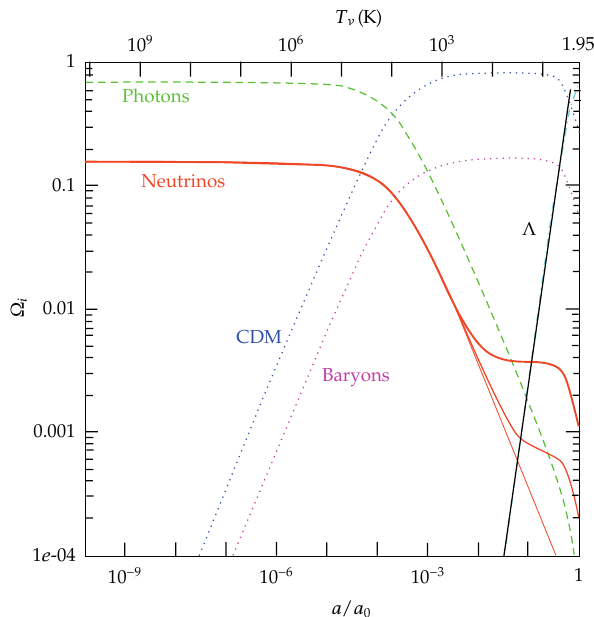
Figure 2: Evolution of the background energy densities in terms of the fractions Ω i , from the time when T ν (cid:7) 1MeV until now, for each component of a flat universe with h (cid:7) 0 . 7 and current density fractions (cid:7) 0 . 05, and Ω (cid:7) 1 − Ω Λ − Ω − Ω ν . The three neutrino masses are m Ω Λ (cid:7) 0 . 70, Ω b cdm b and m 3 (cid:7) 0 .